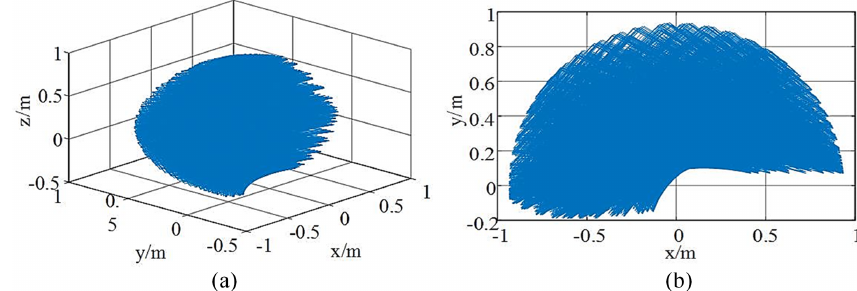
Figure 5. Schematic workspace with initial link size. (a) Three-dimensional workspace. (b) Workspace XY plane